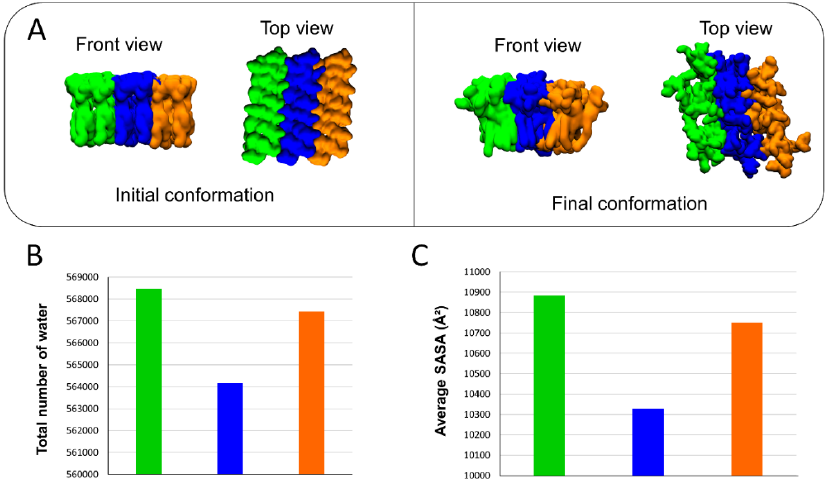
Figure 8. ( A ) Initial and final conformations of the GM1 lipid raft. The orange surface represents the periphery of the lipid raft that does not accommodate AmyP53. The blue surface is the middle part of the lipid raft, while the green color represents the surface which accommodates AmyP53. ( B ) Plot showing the total number of water molecules that surround the corresponding part of the lipid raft over time. ( C ) Average SASA (solvent-accessible surface area) for each different part of the lipid raft over the time.